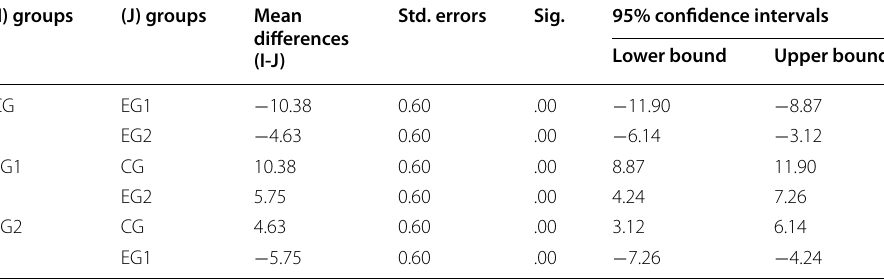
Table 5 Results of the Scheffe post-hoc test: the participants’ post-test of speaking fluency scores (I) groups (J)